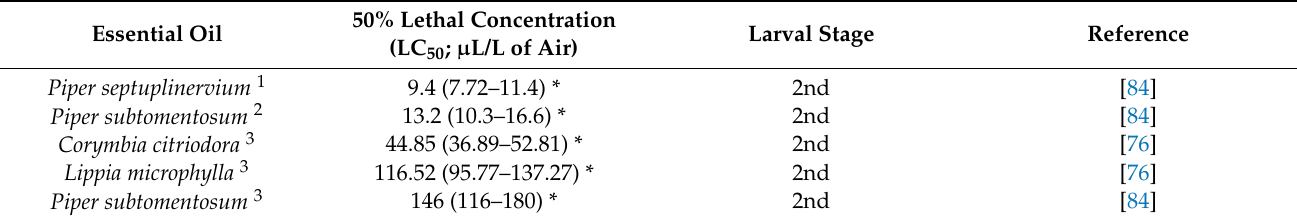
Table 8. Lethal effects of EOs tested by